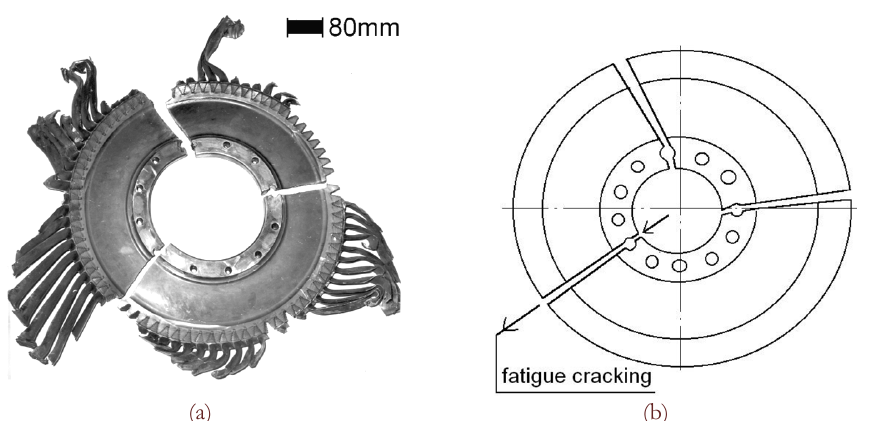
Figure 2: (a) General view of the Stage-III turbine disk of a NK8-2u engine; (b) Scheme of the disk cracking sequence. Arrows indicate the disk section in that initial fatigue crack propagated.